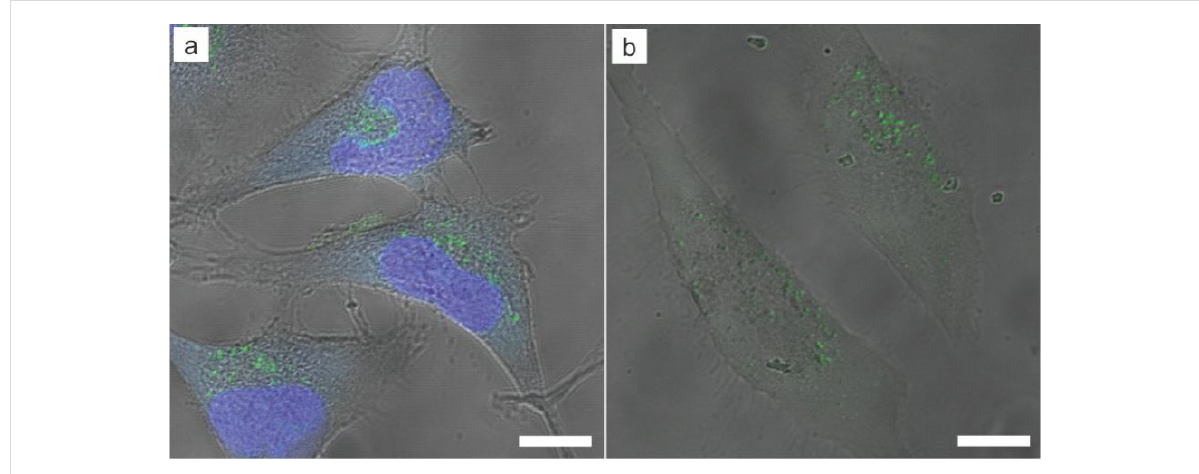
Figure 14: CLSM images of HeLa cells co-incubated with Au@MnO@SiO 2 -Atto495 Janus particles (green) for 24 h at 37 °C (c(Mn 2+ ) = 100 µg/mL). a) λ ex = 488 nm, cell nuclei were stained using DAPI, b) two-photon image of the same sample, λ ex (2P) = 970 nm. Scale: 10 µm. Adapted with permission from [39]. Copyright 2014 American Chemical Society.